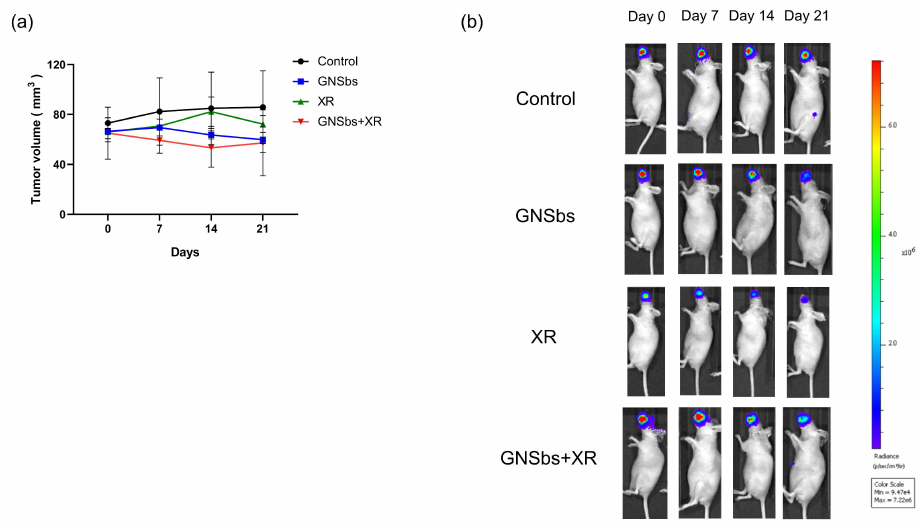
Figure 8. ( a ) The volume of tumors was recorded at day 0, day 7, day 14, and day 21. The treatment started at day 1. ( b ) IVIS images of tumor-induced nude mice treated with GNSbs and X-ray. Each mouse was measured by IVIS on days 0, 7, 14, and 21 after different